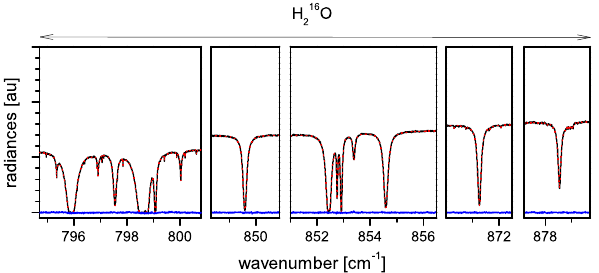
Fig. 1. Spectral microwindows of the 790 - 880 cm − 1 retrieval taken from a spectra measured on the 18th of October 2009, at a solar elevation of 17 . 8 ◦ , and for a total water vapour column amount of 5 mm. Black line: measured spectrum; Red line: simulated spec- trum; Blue line: residuals (difference between measurement and simulation).